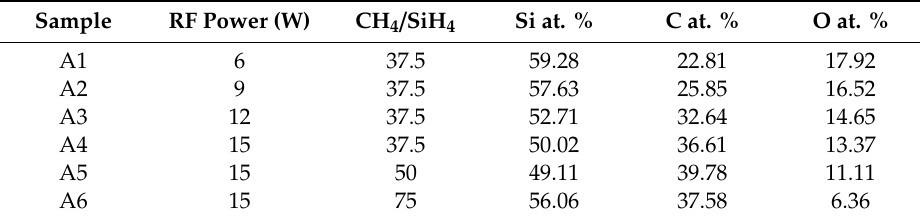
Table 2. Atomic composition obtained by Energy-Dispersive Spectroscopy (EDS) of the as-deposited a-Si 1 − x C x :H